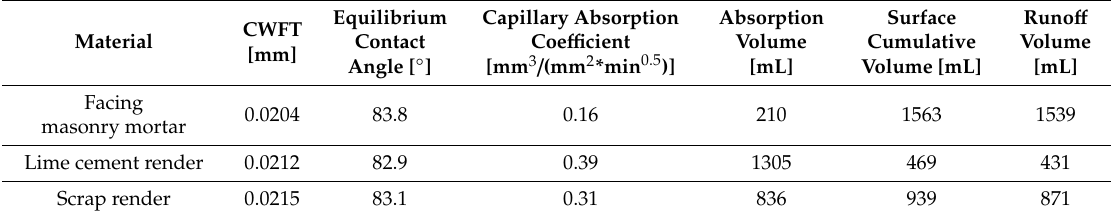
Table 1. Cumulative water film thickness (CWFT) simulation results for the three di ff erent plasters after 7200 s (2 h). Absorption coe ffi cient values according to DIN EN 998-1 [34] and contact